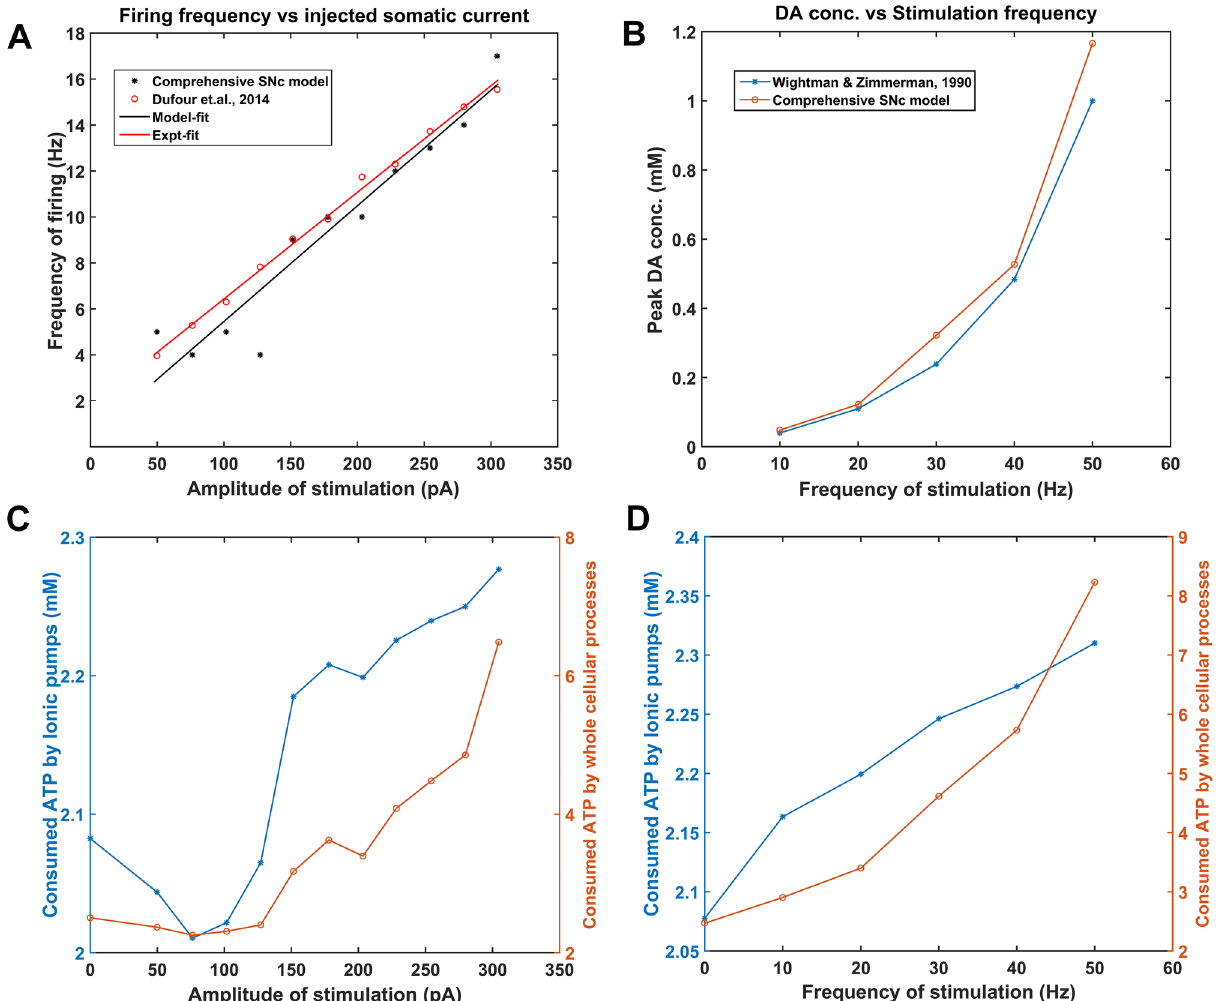
Figure 3. Model response to electrical stimulation. Frequency of firing ( A ) and Energy consumption ( C ) by ionic pumps (blue trace) and all other (whole) cellular processes (orange trace) of the model concerning the amplitude of stimulating depolarized current (1 s), Extracellular dopamine concentration ( B ) and Energy consumption ( D ) by ionic pumps (blue trace) and all other (whole) cellular processes (orange trace) of the model concerning the frequency of stimulating depolarized current (2 secs). ATP adenosine triphosphate, Hz Hertz, pA picoampere, mM